Question: Judging by this figure, is the value going up or going down?
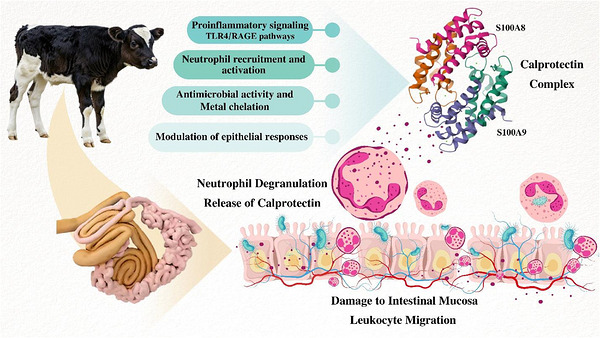
Answer: increasing